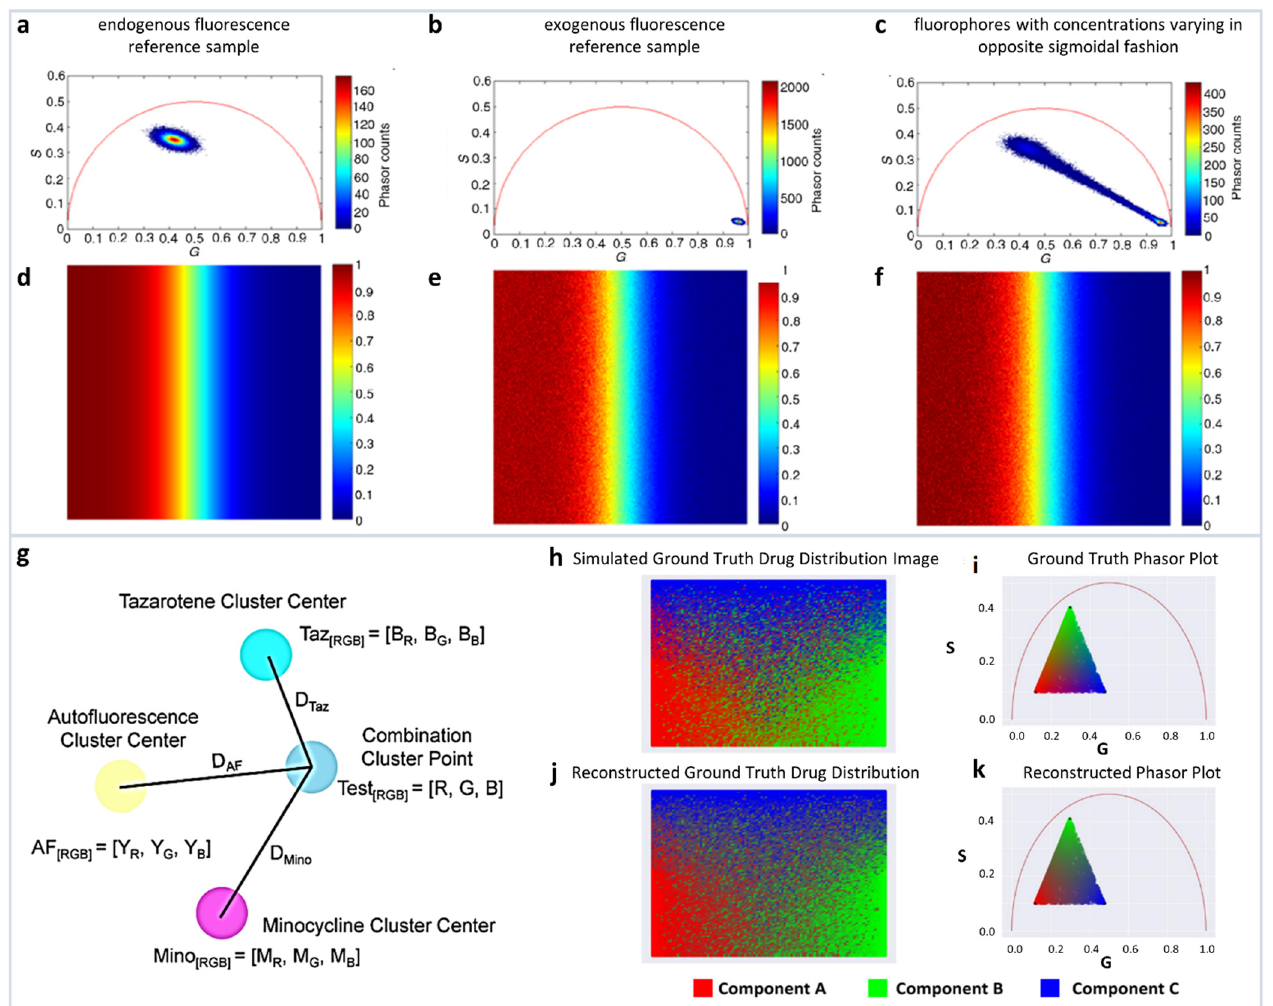
Figure 4. Multicomponent analysis based on non-Euclidean geometry. ( a – c ) Simulation to validate the proposed non-Euclidean separation algorithm. ( a ) Phasor plot of simulated endogenous fluorescence reference sample, ( b ) exogenous fluorescence reference sample, ( c ) fluorophores with concentrations varying in opposite sigmoidal fashion. ( d – f ) Three-component analysis of drug distribution using non-Euclidean geometry. Simulated endogenous fluorescence contribution to the test image. Estimation of endogenous fluorescence contribution computed using the traditional Euclidean method and using the proposed non-Euclidean method. (Panels a – f adapted with permission from [37]). ( g – k ) Distance-based method of assigning phasor plot pixel colors in a multicomponent fluorescence contribution analysis algorithm. ( g ) A sample setup of a distance calculation. Yellow, cyan, and magenta points → the center of exogenous (autofluorescence), and two endogenous reference clusters (TAZ and MNC), respectively, and blue point → a phasor point from the tissue sample. ( h , i ) Simulated ground truth tissue map of drug distribution and calculated phasor plot. ( j , k ) Reconstructed tissue drug distribution using the multicomponent phasor analysis algorithm and phasor plot. (Panels g – k adapted with permission from [36]).